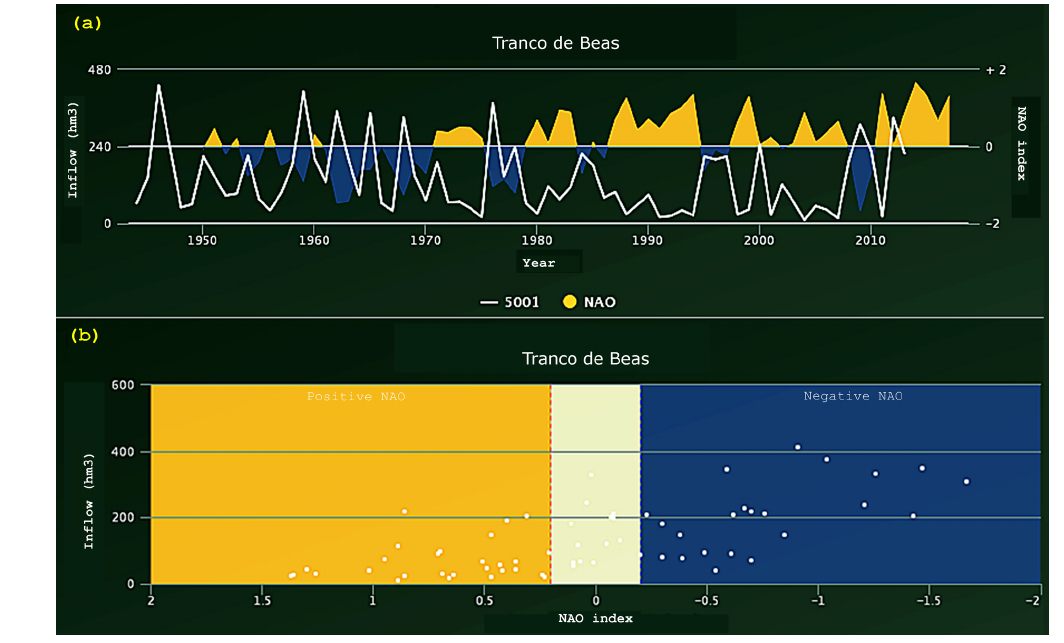
Figure 3. Graphs in diagnostic view showing: (a) time evolution for extended winter reservoir inflow (white line, left y -axis) and NAO index (orange/blue shadow for ± DJF NAO, right y -axis); (b) scatterplot for extended winter reservoir inflow and NAO